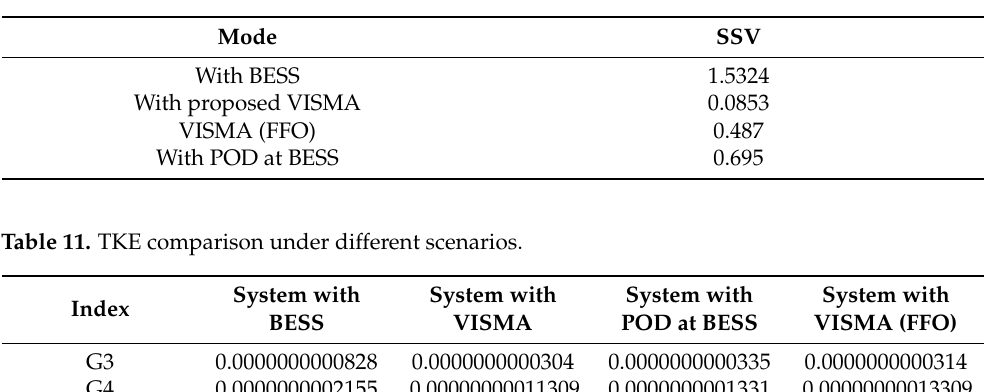
Table 10. SSV assessment results.